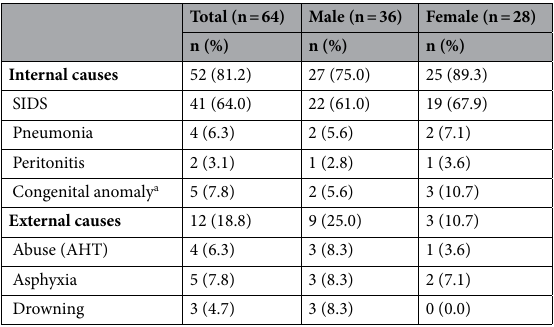
Table 2. Causes of death in 64 infant autopsy cases. a Congenital anomaly includes an anomalous origin of the coronary artery, a complex congenital heart disease, and an alveolar capillary dysplasia. AHT, abusive head trauma; SIDS, sudden infant death